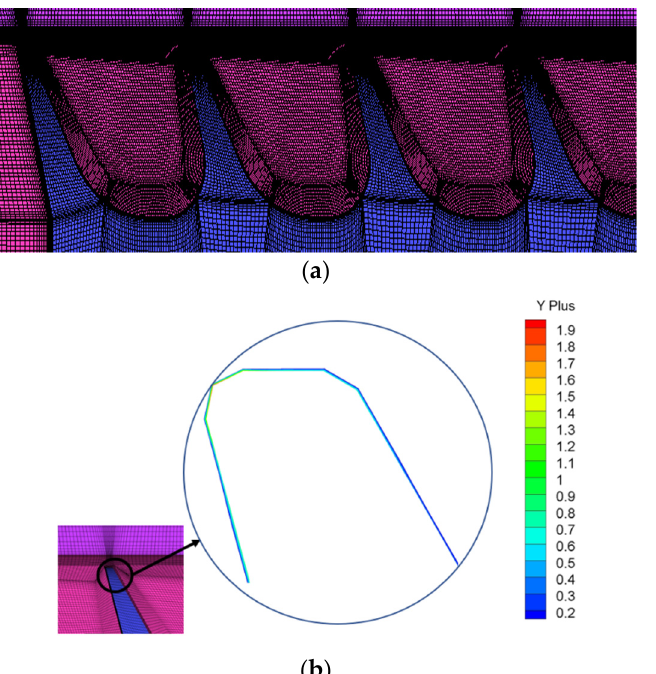
Figure 3. The grid of labyrinth seals. ( a ) The entire grid of labyrinth seals; ( b ) encrypted partial grid and contour of y+ values.